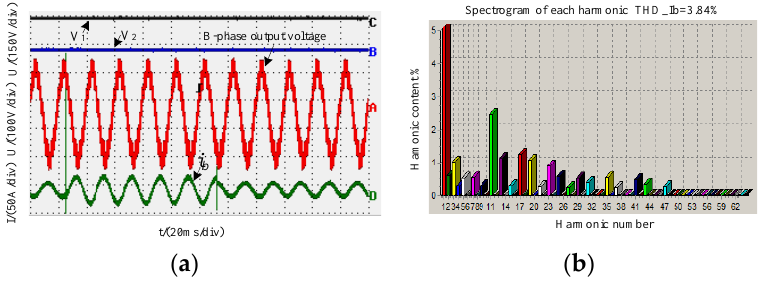
Figure 25. Compensated waveforms: ( a ) current of power grid; capacitor voltage and output voltage, ( b ) THD of B-phase current.